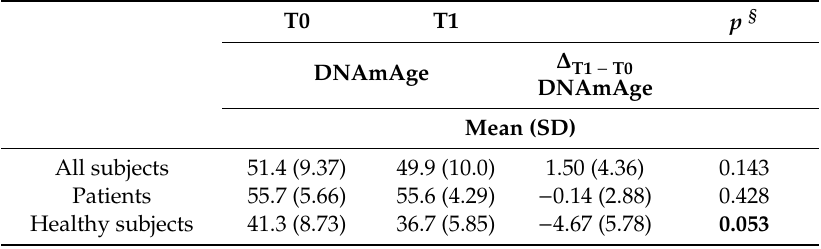
§ Paired two sided t